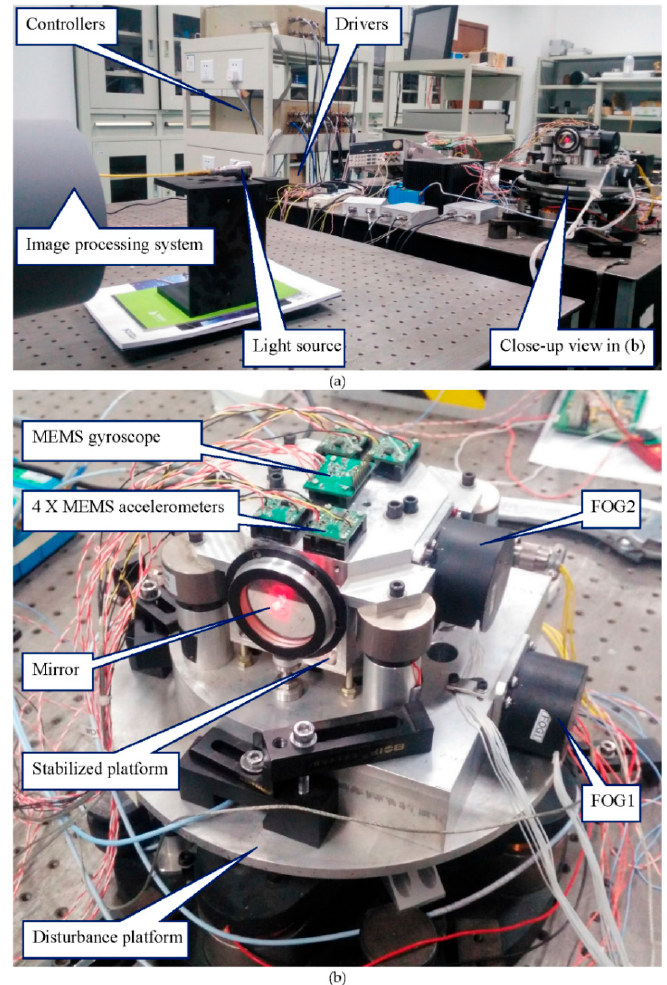
Figure 9. Experimental apparatus: ( a ) global diagram; ( b ) local diagram.